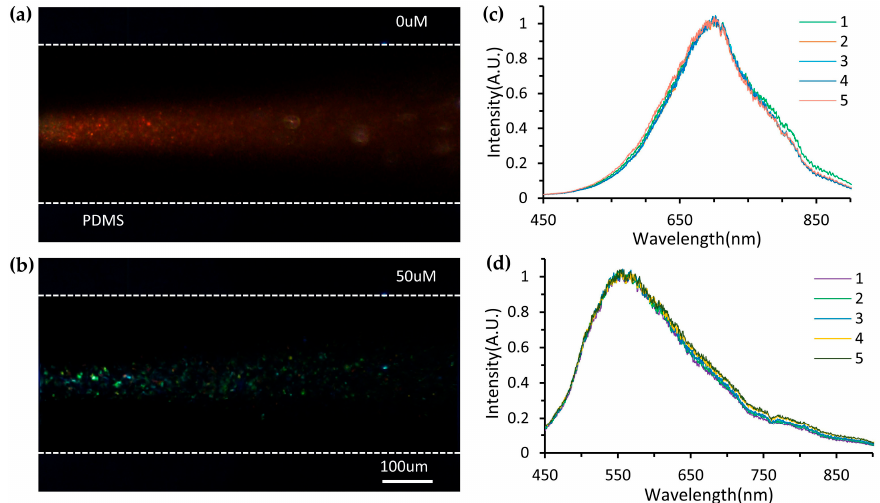
Figure 4. Images and spectra of the Ag nanoprisms illuminated by supercontinuum whitelaser. ( a , b ) Scattering images of silver nanoprisms before and after DO measurement (50 µM, 1.6 mg/L). And their corresponding normalized extinction spectra captured through the optical detection module ( c , d ). The spectra of the sample flow were collected five times, 10 s apart.